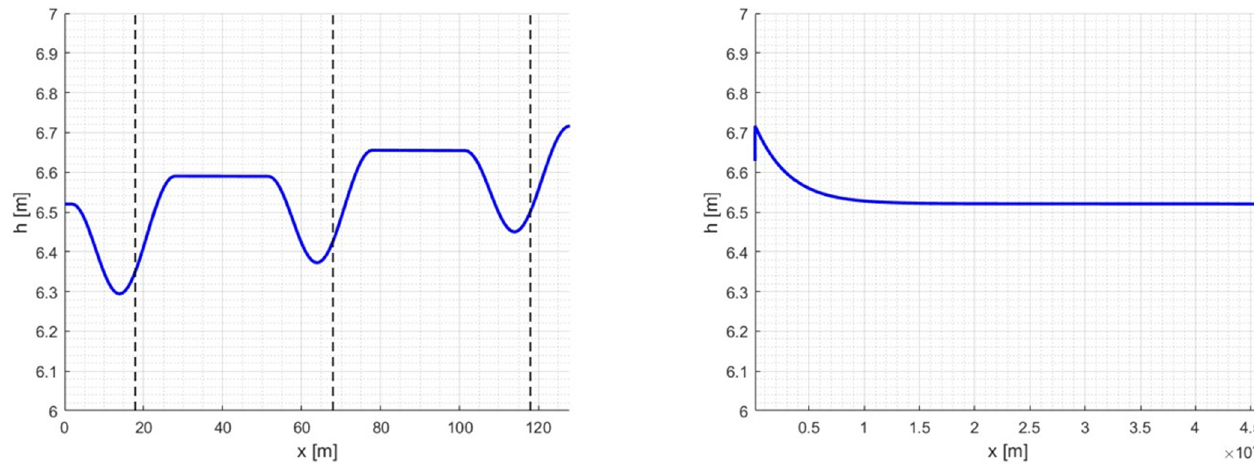
Figure 9. ( Left ) Example of free surface variation based on three turbine arrays of four 6 m 2 turbines vs. distance with array spacing of 50 m. The local free surface variation past the turbines is visualized for the central rotors. ( Right ) Effect of the asymptotic backwater past the three turbine arrays.